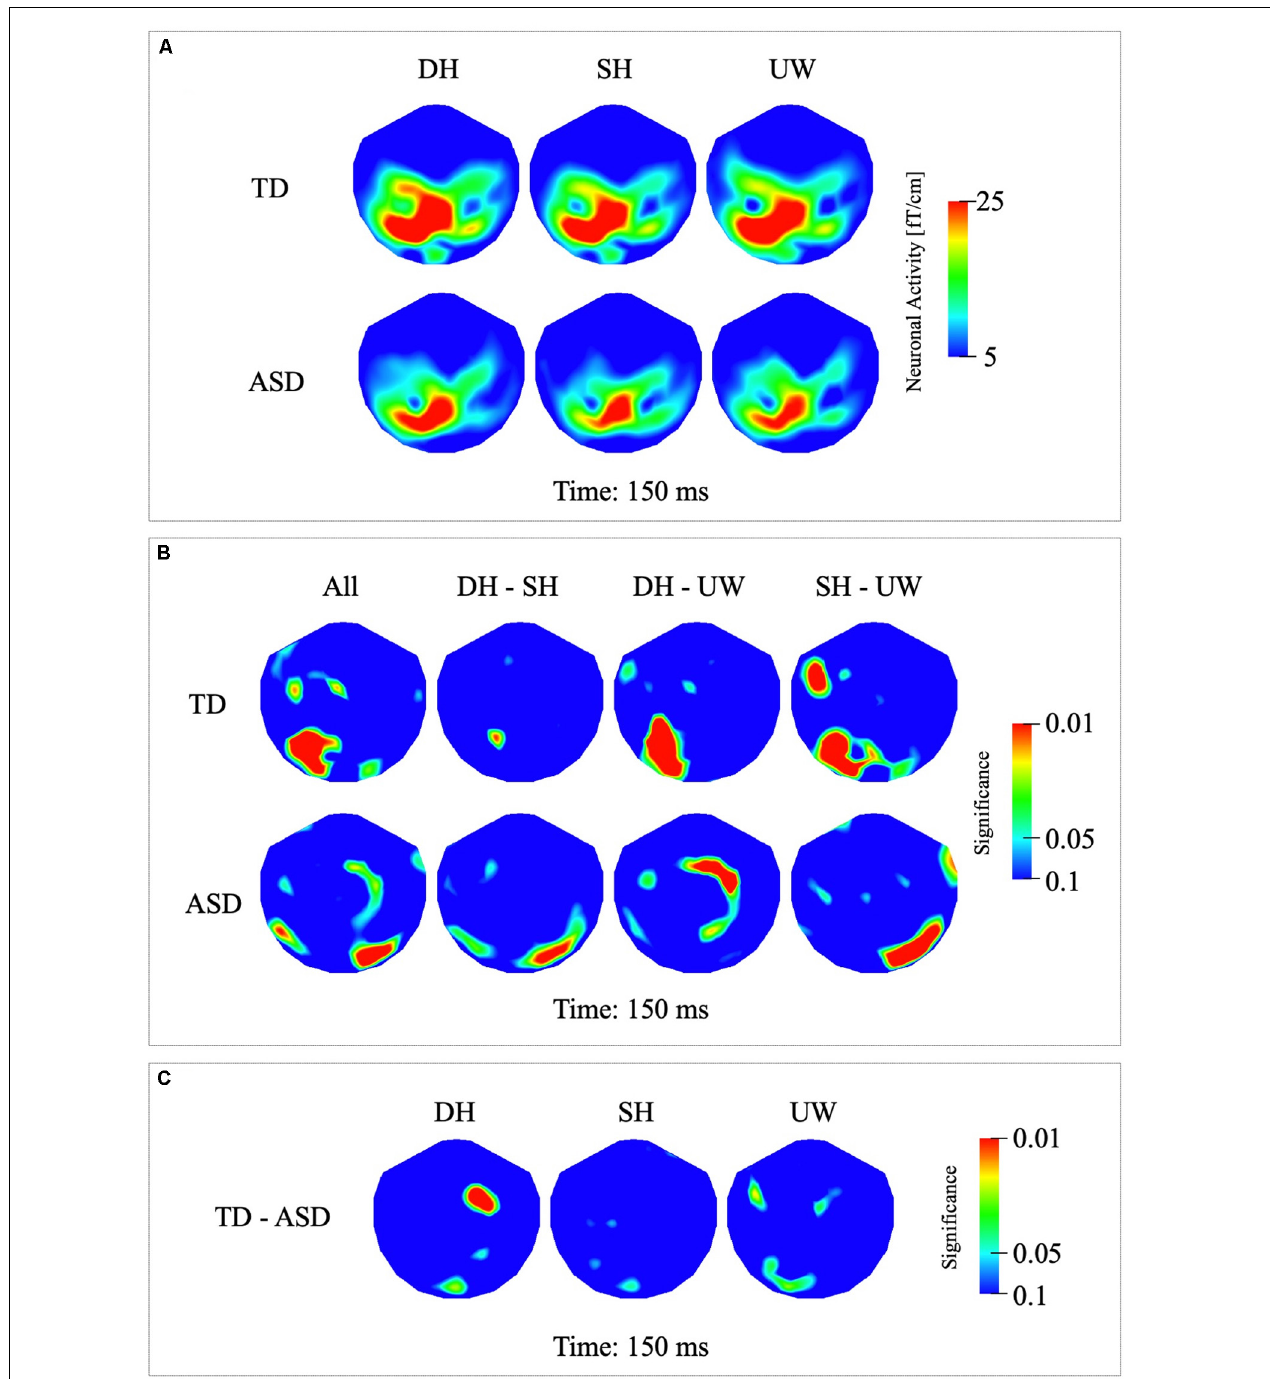
FIGURE 2 | (A) First row: Local RMS-maps for the TD group’s responses to final words (dominant homonym, subordinate homonym, and unambiguous word) at 150 ms. Second row: Local RMS-maps for the ASD group’s responses to final words (dominant homonym, subordinate homonym, and unambiguous word) at 150 ms. (B) First row: TD group’s Friedman analysis result for dominant homonym, subordinate homonym, and unambiguous word at 150 ms. Wilcoxon pairwise analysis result of dominant homonym and subordinate homonym, dominant homonym and unambiguous word, and subordinate homonym and unambiguous word at 150 ms. Second row: ASD group’s Friedman analysis result for dominant homonym, subordinate homonym, and unambiguous word at 150 ms. Wilcoxon pairwise analysis result of dominant homonym and subordinate homonym, dominant homonym and unambiguous word, and subordinate homonym and unambiguous word at 150 ms. (C) Mann–Whitney U analysis result for TD vs. ASD groups’ responses to final words (dominant homonym, subordinate homonym, and unambiguous word) at 150 ms. For the presentation of data, the detectors have been projected into two dimensions (right ear on the right, front at the top).